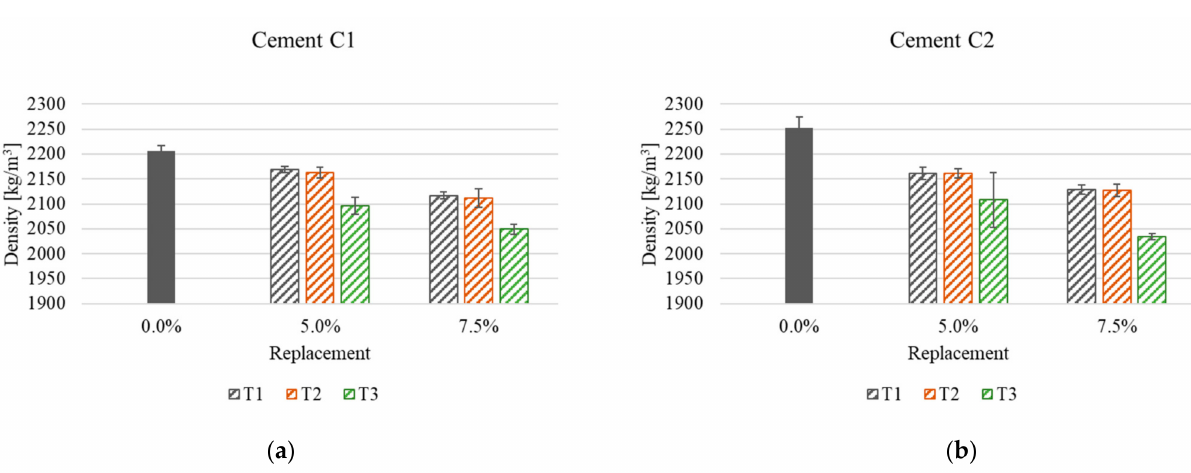
Figure 11. Density of rubber-added mortar under treatment R1 at 5% and 7.5% replacement, after 14 days: ( a ) cement C1; ( b ) cement